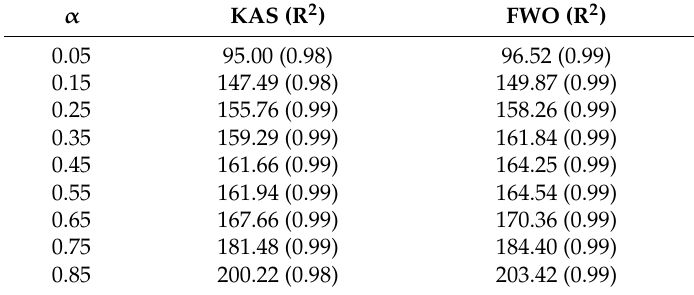
Figure 8. Histogram of KAS method and FWO method for F-lignin@APP20 / EP. Table 3. Activation energy of Al-lignin 20 / EP obtained from the KAS method and FWO